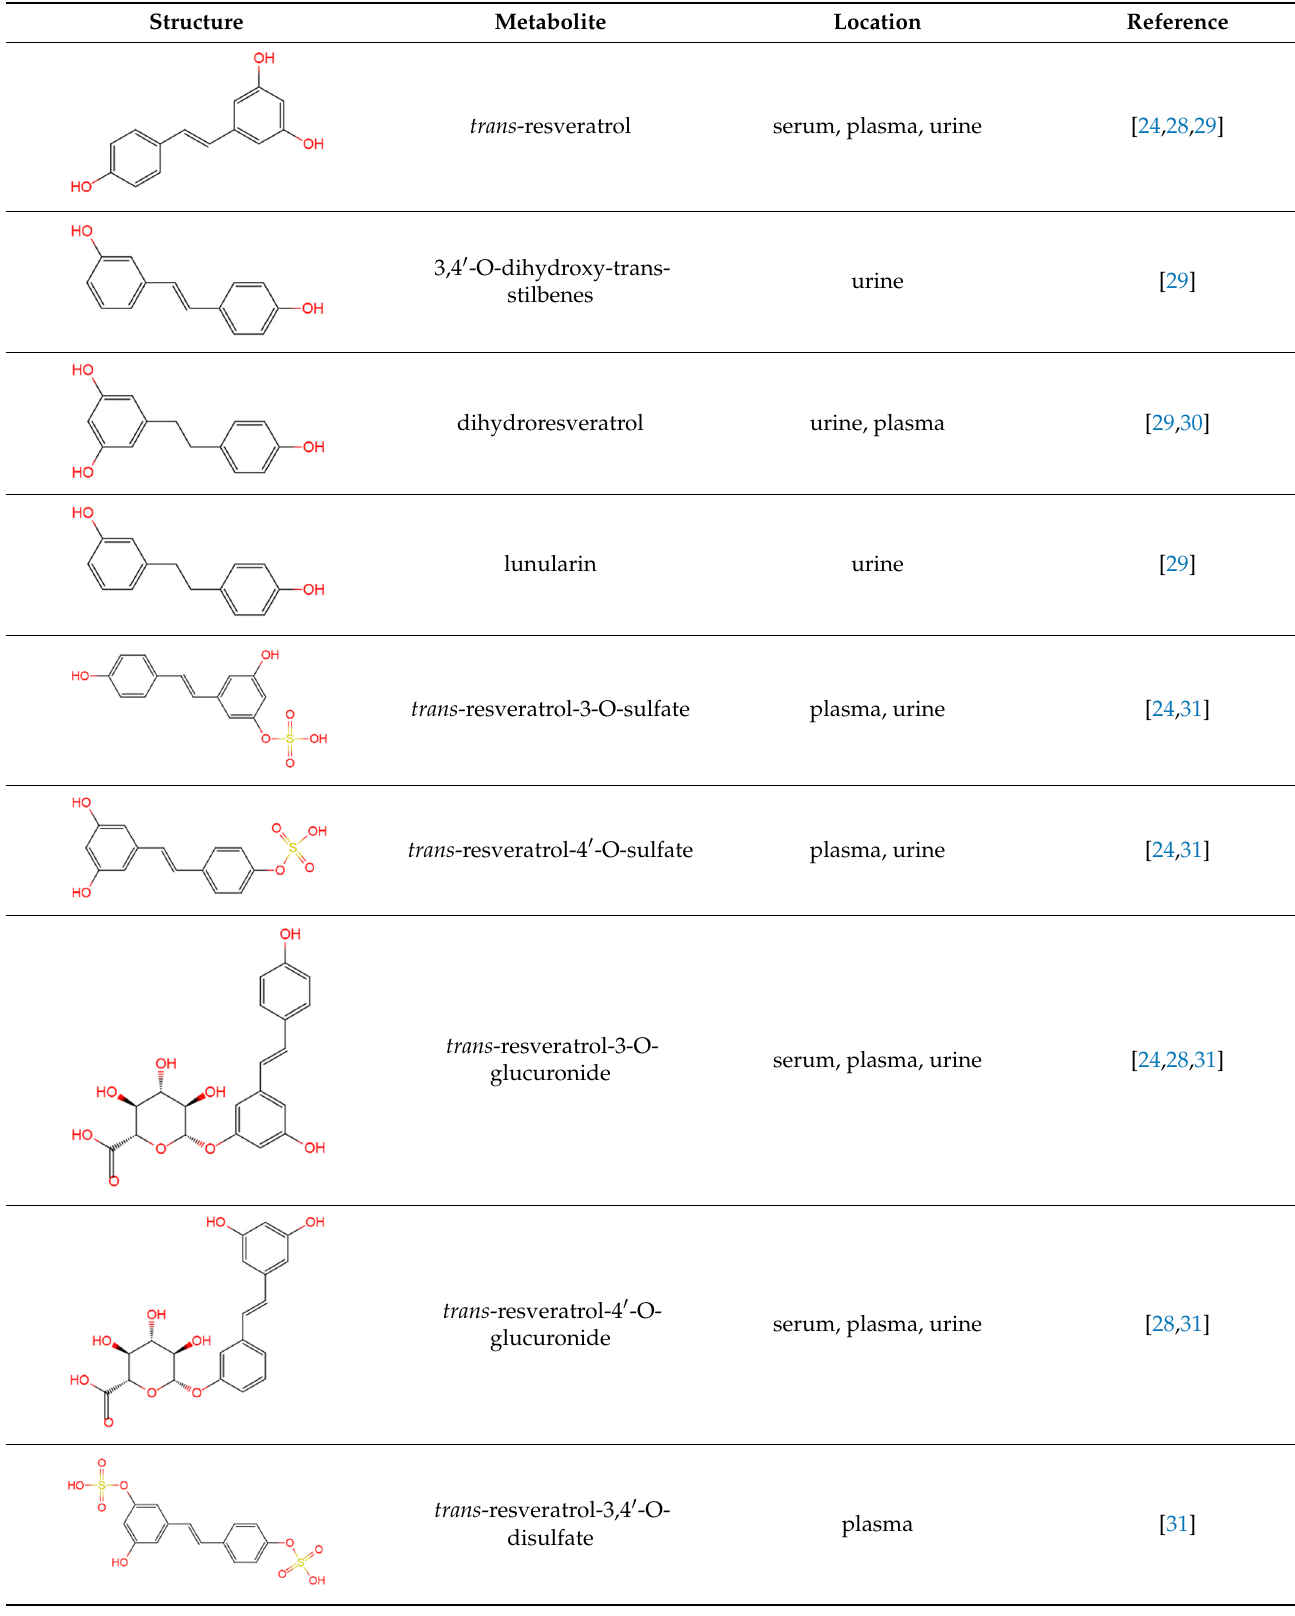
Table 1. Human oral administration of resveratrol metabolites in different liquids and tissues.